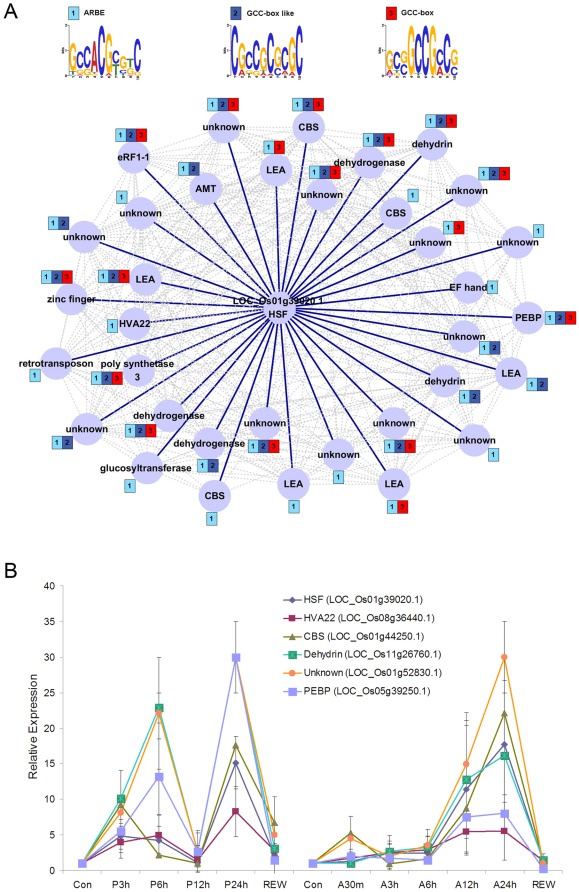
Co-expression relationship of HSF with its related genes.A, gene co-expression network and putative binding sites for HSF. B, the average expression levels of HSF and its neighborhood genes under PEG and ABA treatments. The error bars represent standard deviation from the mean.